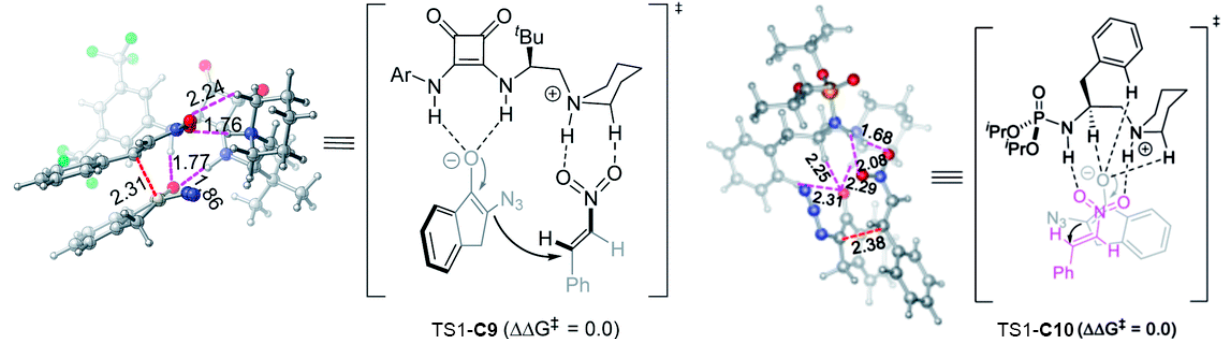
Figure 14. The optimized structures for the transition states of the squaramide and phosphoramide catalyzed reactions between 18a (R 1 = H) and 7b (7 , R = Ph). Only the lowest energy structures (with ΔΔ G ǂ = 0.0) are shown. The bond distances are given in Å. The relative Gibbs free energies are in kcal mol − 1 , calculated at the IEFPCMM06-2X-D3/6-311++G(d,p)//IEFPCM-M06-2X/6-31G(d,p) level. Reprinted and adapted from Chemical Science with permission from Royal Society of Chemistry [37].